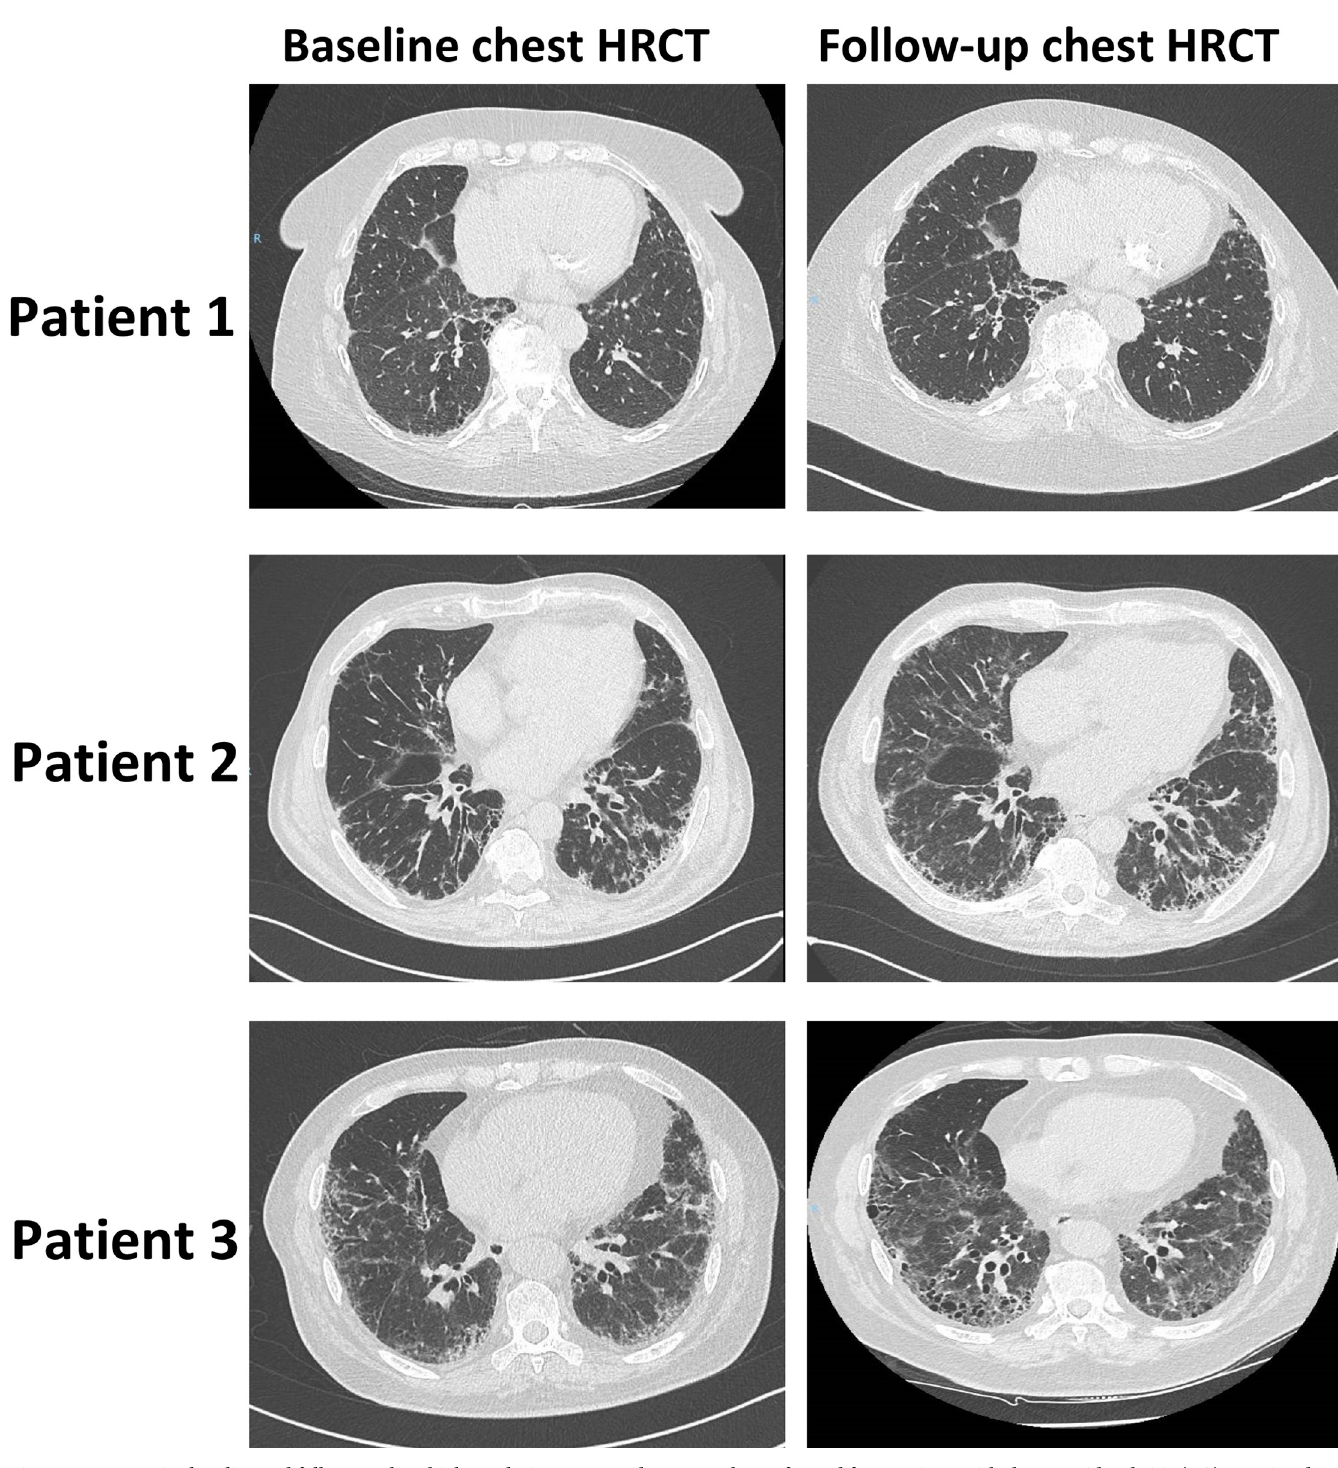
Fig 2. Representative baseline and follow-up chest high-resolution computed tomography performed for 3 patients with rheumatoid arthritis (RA)-associated interstitial lung disease (ILD). Patient 1: baseline KL-6 concentration of 543 U/mL, with no ILD progression detected on chest high-resolution computed tomography (HRCT). Patient 2: baseline KL-6 concentration of 1,412 U/mL, with ILD progression detected on chest HRCT. Patients 3: baseline KL-6 concentration of 4,414 U/mL, with ILD progression detected on chest HRCT.